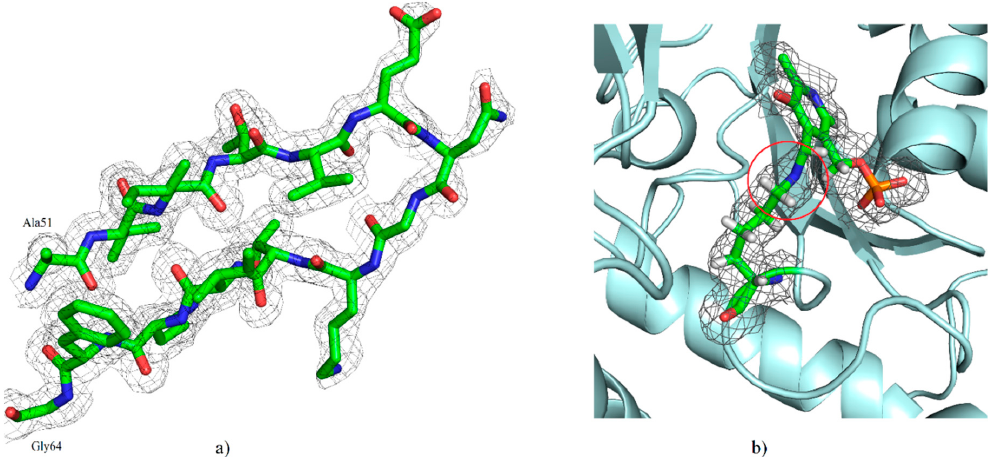
Figure 2. ( a ) Illustrative electron-density depiction from the final 2Fo–Fc map (grey at the 1.0 σ level), highlighting the agreement of antiparallel β -sheets ( β 1– β 2; between Ala51 and Gly64) with the maps; ( b ) The 2Fo-Fc electron density map (grey at the 0.5 σ level) of lysine-pyridoxal-5 ′ -phosphate (LLP)263, in which the aldimine linkage is highlighted by a red circle.